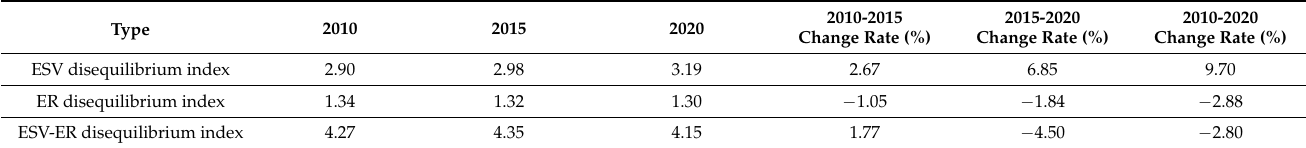
Table 8. Disequilibrium index between ESV and ER.